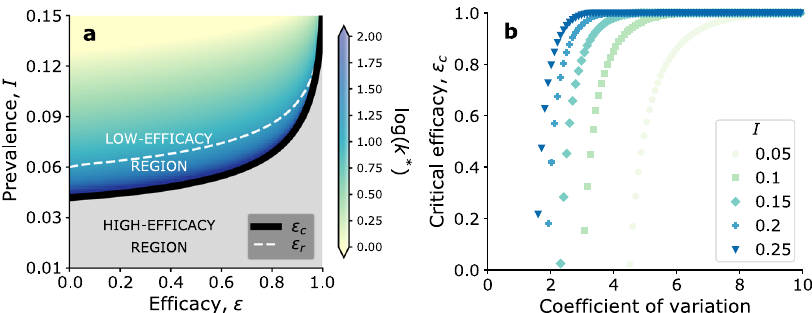
Fig. 2 Critical ef fi cacy, and the low-ef fi cacy region. a k * as a function of ef fi cacy ϵ , and baseline disease prevalence (prevalence without prevention). Finite values of k * mark the low-ef fi cacy region. The gray area indicates k * → ∞ : the high-ef fi cacy region. The solid black lines shows critical ef fi cacy ϵ c ; the dashed black line shows ϵ r . The degree distribution is a negative binomial with mean 2.0, coef fi cient of variation 9.4. The reduced transmissibility ^ λ is numerically set to match the corresponding baseline prevalence. b Critical ef fi cacy ϵ c as a function of the heterogeneity of the contact network, measured as the coef fi cient of variation of a negative binomial distribution with mean 2.0. Different curves mark different values of baseline